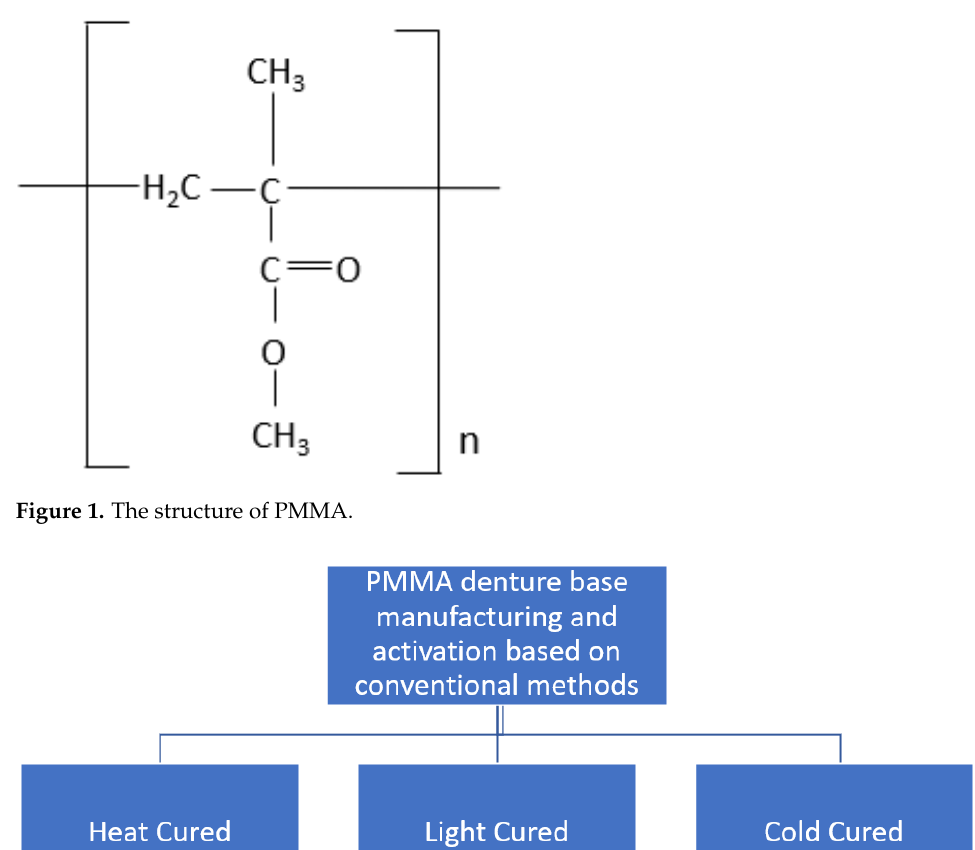
Figure 2. Denture base fabrication conventionally based on PMMA material.